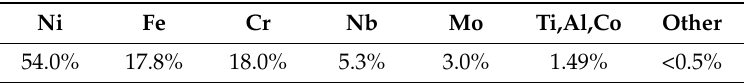
Table 1. Composition (wt %) of the Inconel 718 samples used in this